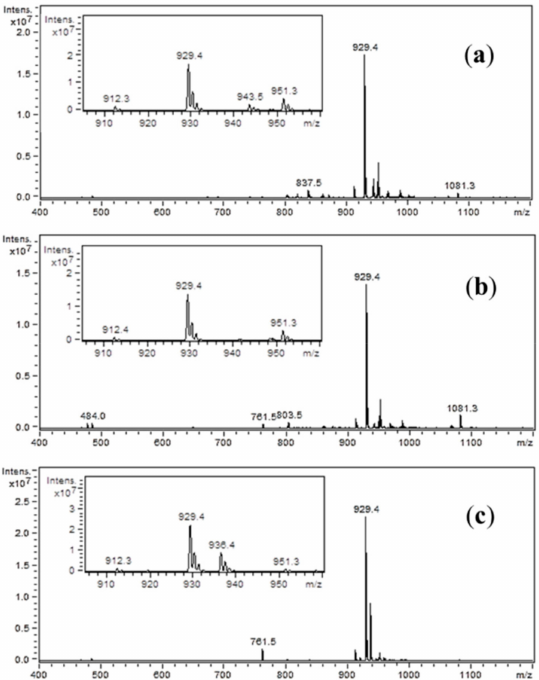
Figure 3. Mass spectra of the synthesized inhibitor (IAA-Leu-Tyr-Ahx-Lys(biotin)-NH 2 ), after iodoacetic acid conjugation using several coupling methods: ( a ) COMU / DIPEA; ( b ) DIC; ( c ) DIC / HOBt.